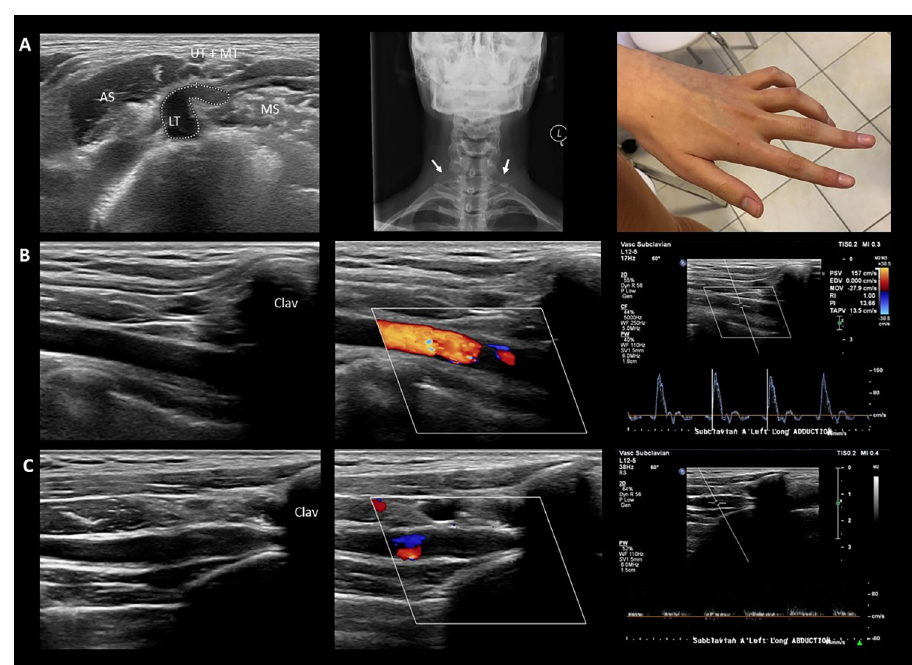
Fig 4. Multilevel compression in neurogenic TOS. Images of a 20-year-old female patient with neurogenic (supra- + costoclavicular) TOS, demonstrating both supraclavicular ‘wedge-sickle sign’ and costoclavicular impingement. Her complaints started 6 months earlier with nocturnal numbness of the left 4-5 th fingers, followed by the development of claw hand, indicating dysfunction of the 4-5 th lumbricalis / interosseous (lower trunk innervated) muscles. Apart from the claw hand and minor sensory disturbance in the distribution area of the lower trunk, she had no neurological deficit. Electrophysiological assessment was normal. A . The image on the left is an axial scan of the supraclavicular fossa showing a typical fibromuscular ‘wedge-sickle sign’. Note the sickle-shaped, swollen and hypoechoic lower trunk. The hyperechoic fibromuscular structure in this case is a fibrous band connecting an elongated transverse process of the 7 th cervical vertebra (arrows in the middle image) with the 1 st rib (Type 2 Roos ligament). The image on the right shows her ‘claw hand’. B and C show the vascular ultrasound (B mode, Colour Doppler and PW mode) of the left subclavian artery in the immediate infraclavicular region in neutral arm position ( B ) and during arm abduction ( C ). Note that during arm abduction the artery is narrowed, followed by a poststenotic dilation (‘funnel sign’) as it leaves the costoclavicular space, associated with almost complete occlusion. The patient’s complaints were exacerbated during the manoeuvre. LT: lower trunk; MD: middle trunk; UP: upper trunk; MS: middle scalene muscle; AS: anterior scalene muscle; Clav: